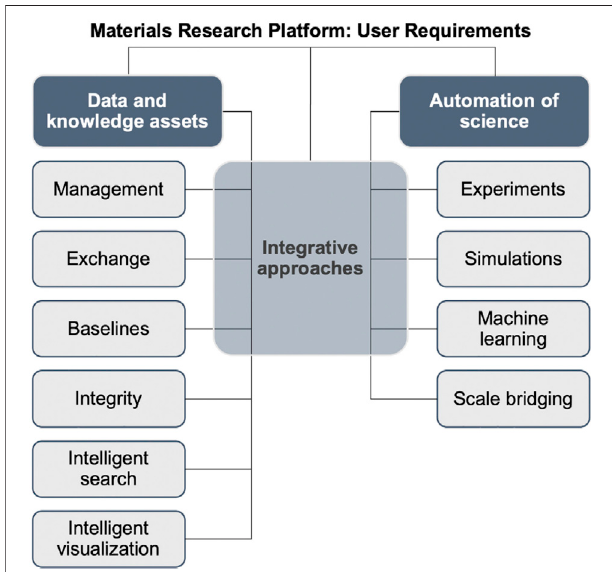
FIGURE 2 | Requirements considered as the Main Pillars of a Materials Research Platform, within three broad themes: Data and Knowledge Assets, Automation of Science on the Platform, and Integrative Approaches. Reproduced from ref. (Aykol et al., 2019).